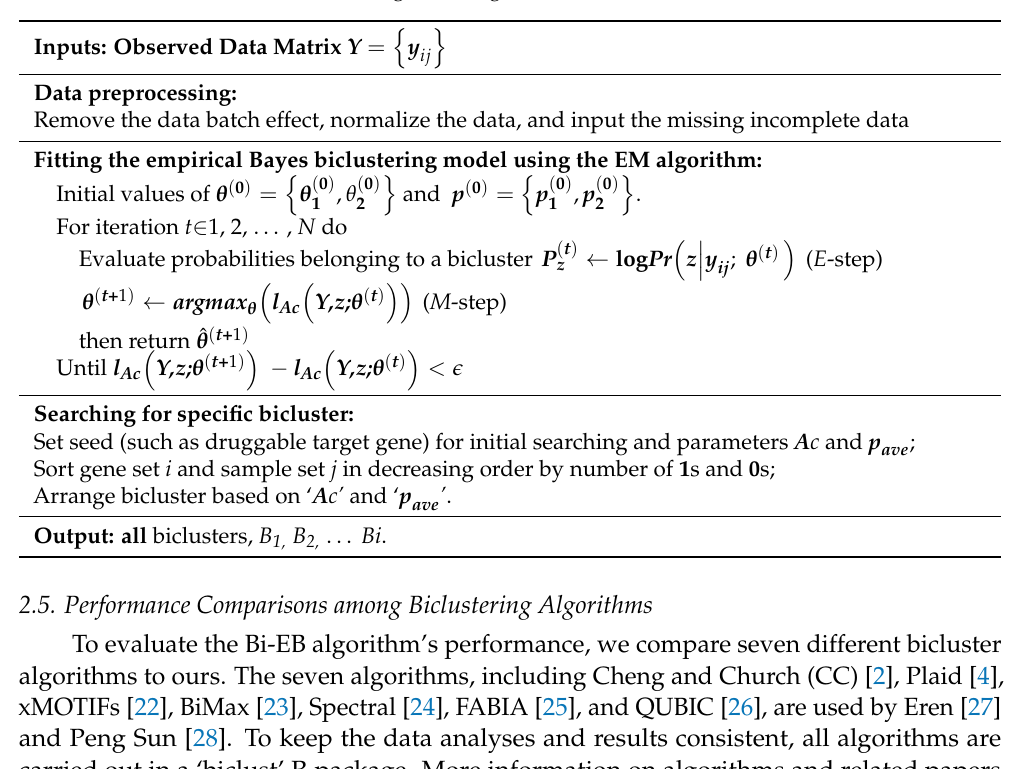
Table 1. Flow-chart for the biclustering Bi-EB